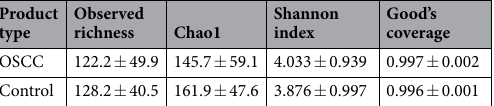
Table 2. Species richness, α -diversity and coverage (mean ± SE) calculated from the rarefied